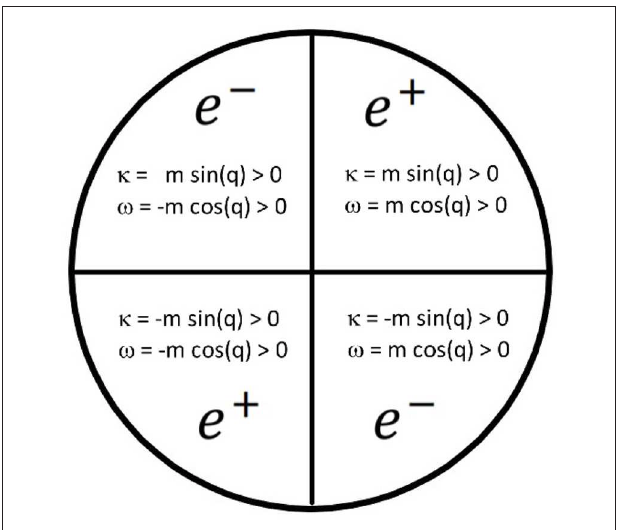
FIGURE 1 | Bound states for electrons and positrons in an electrostatic δ -potential ( λ =